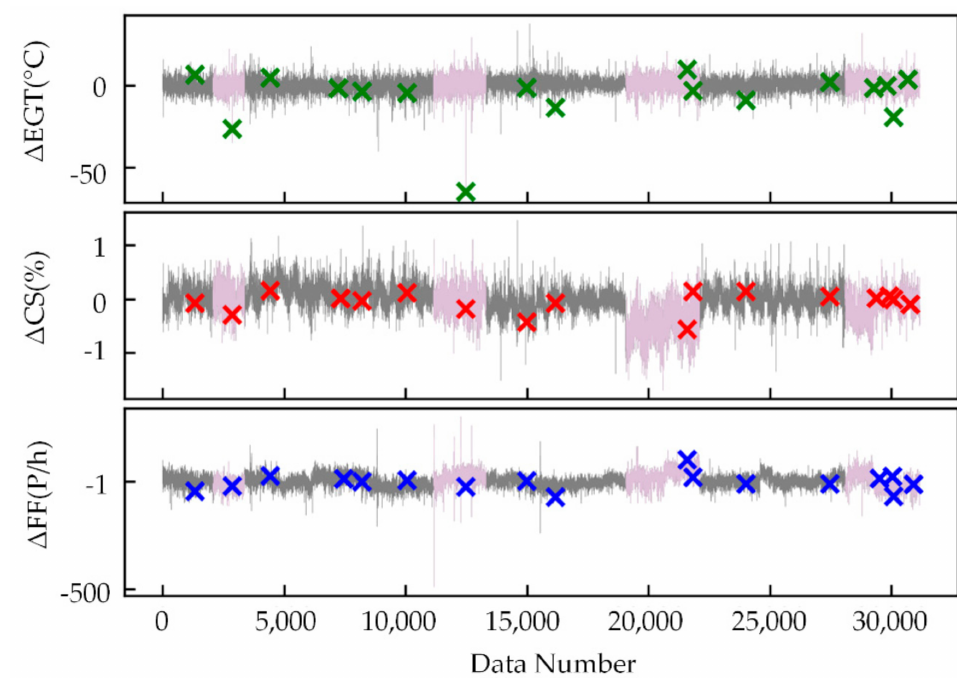
Figure 10. Extracted features trained with new engine